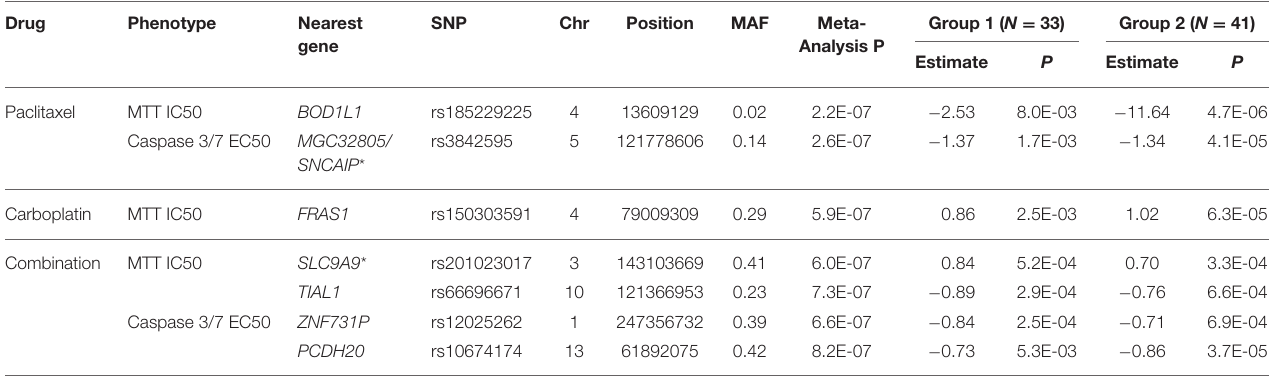
TABLE 1 | SNPs with p < 10 − 6 association with a drug response phenotype. Drug